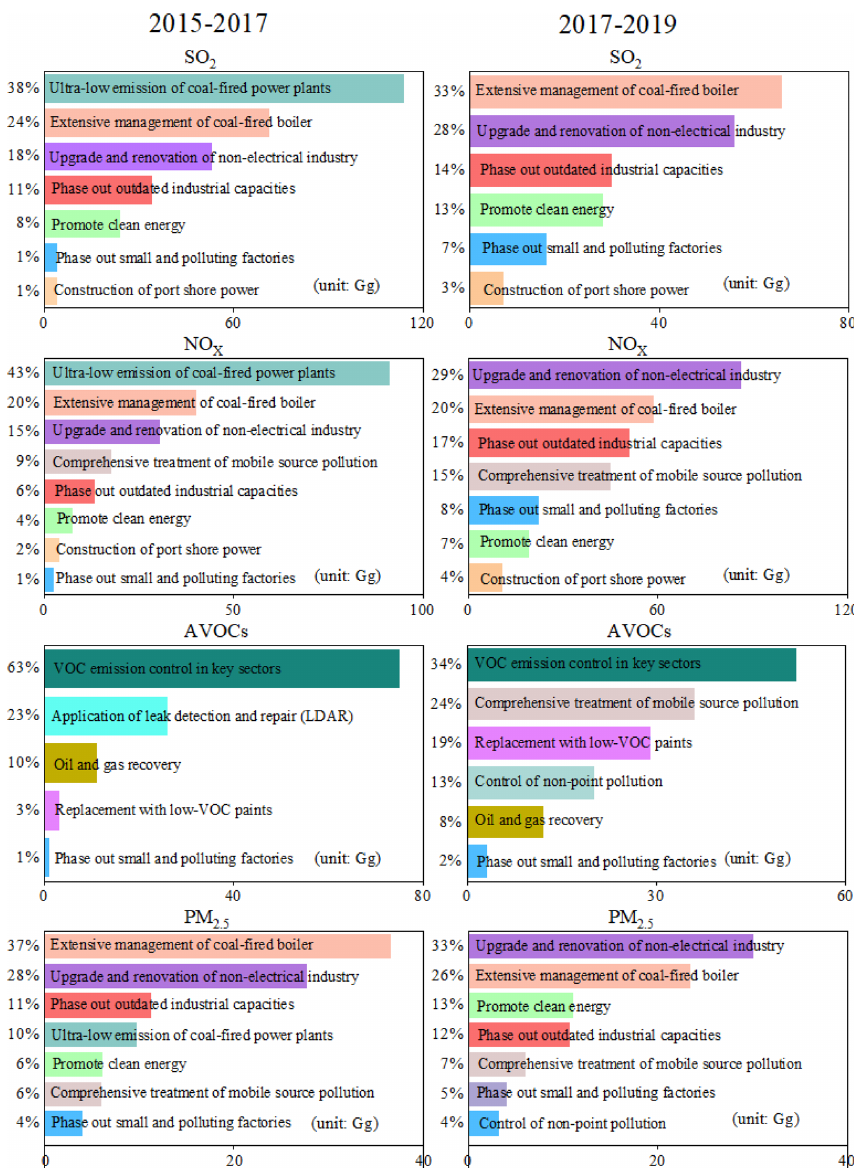
Figure 9. Contributions of individual measures to emission reductions in SO 2 , NO x , VOCs, and PM 2 . 5 for 2015–2017 (the left column) and 2017–2019 (the right